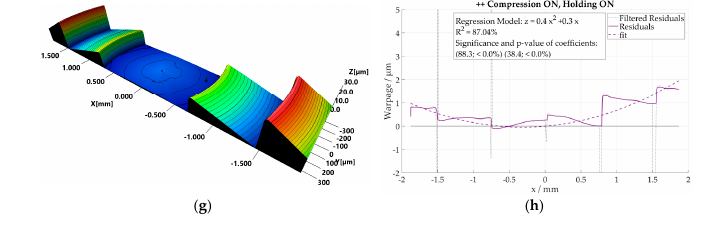
Figure A1. On the left, 3D view of the lens’ central location, sampled as shown in Figure 5. On the right, the residuals of the respective x profiles in comparison with nominal geometry, sampled in the image center. The following process conditions are considered for the COP material results: ( a , b ) IM without holding; ( c , d ) IM; ( e , f ) ICM without holding; ( g , h ) ICM.